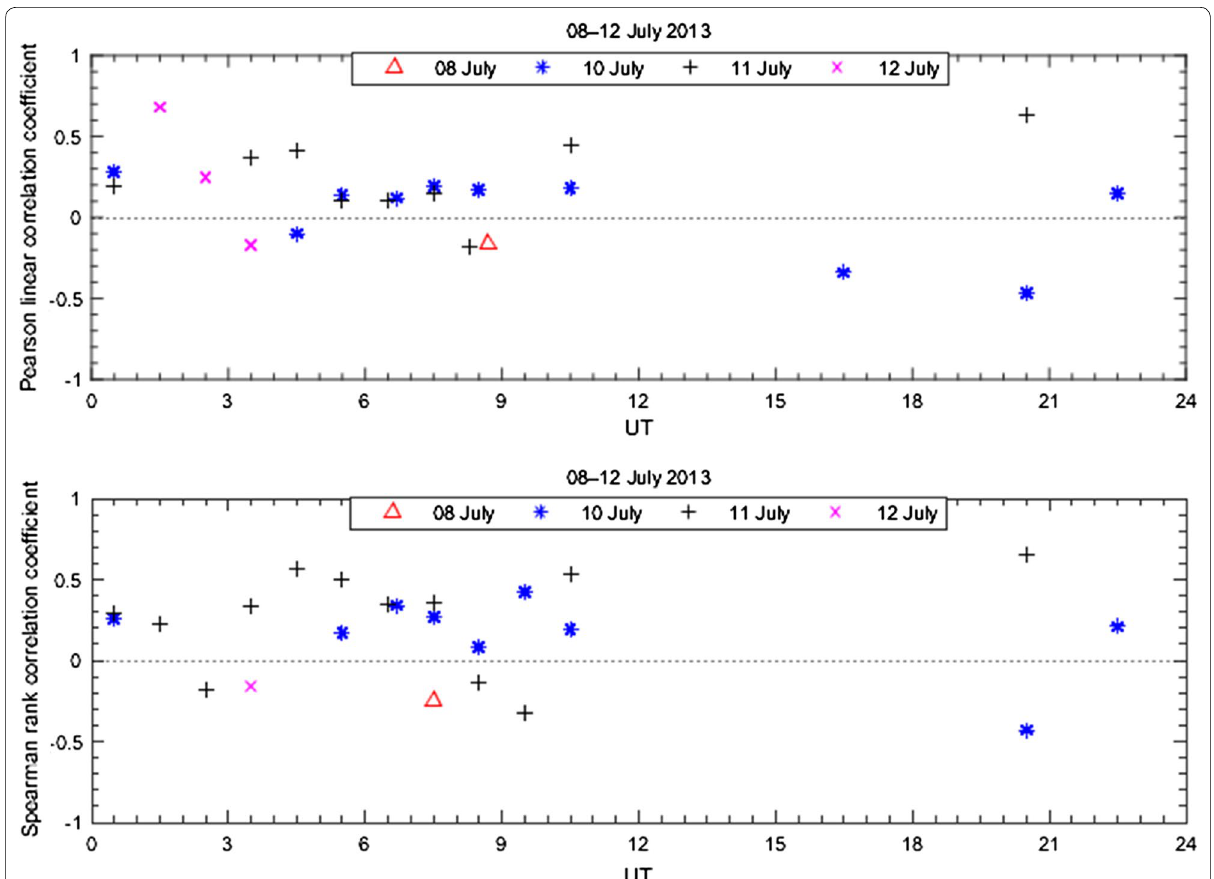
Fig. 4 Pearson linear and Spearman rank correlation coefficient computed for all data points combined having simultaneous occurrence of PMSE and precipitation in each hour. For each correlation coefficient, P value is less than 0.05. The horizontal dotted line is drawn to separate positive and negative correlation